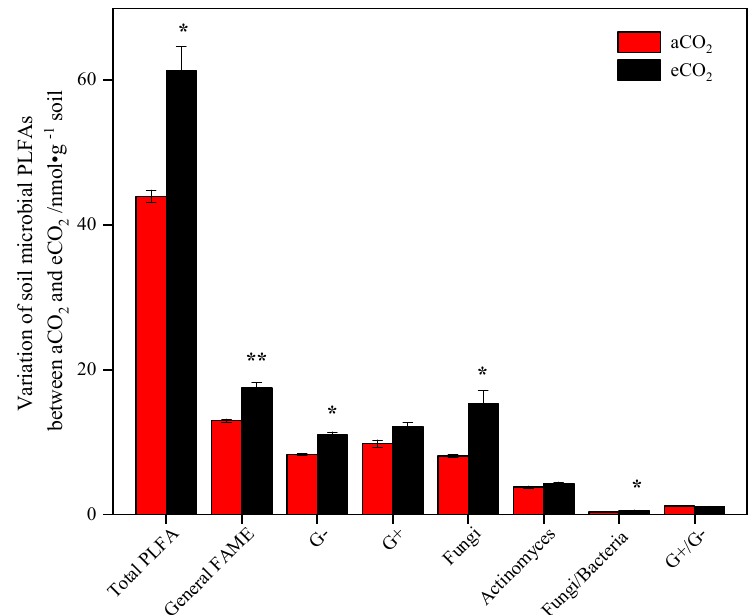
Figure 1. Variation of soil microbial phospholipid fatty acids (PLFAs) between aCO 2 and eCO 2 / nmol · g − 1 soil. p < 0.05, *; p < 0.01, **. The biomarkers for general include 14:0, 15:0, 16:0, 17:0 and 18:0. The biomarkers for gram negative include 16:1 ω 9c, 16:1 ω 7c, 17:1 ω 8c, 18:1 ω 7c, 19:1 ω 8c, 19:0 cyclo